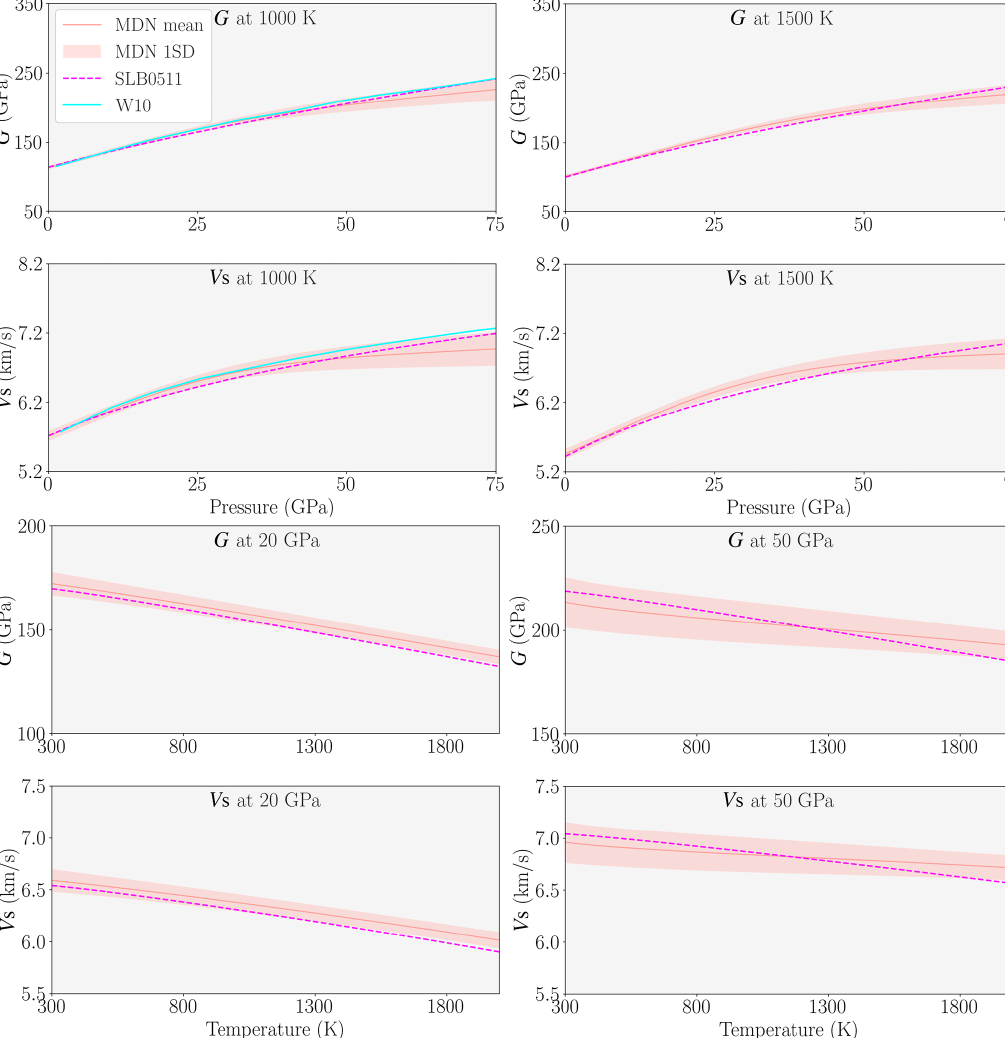
Code availability. The code used in this paper is freely available by contacting the corresponding author.